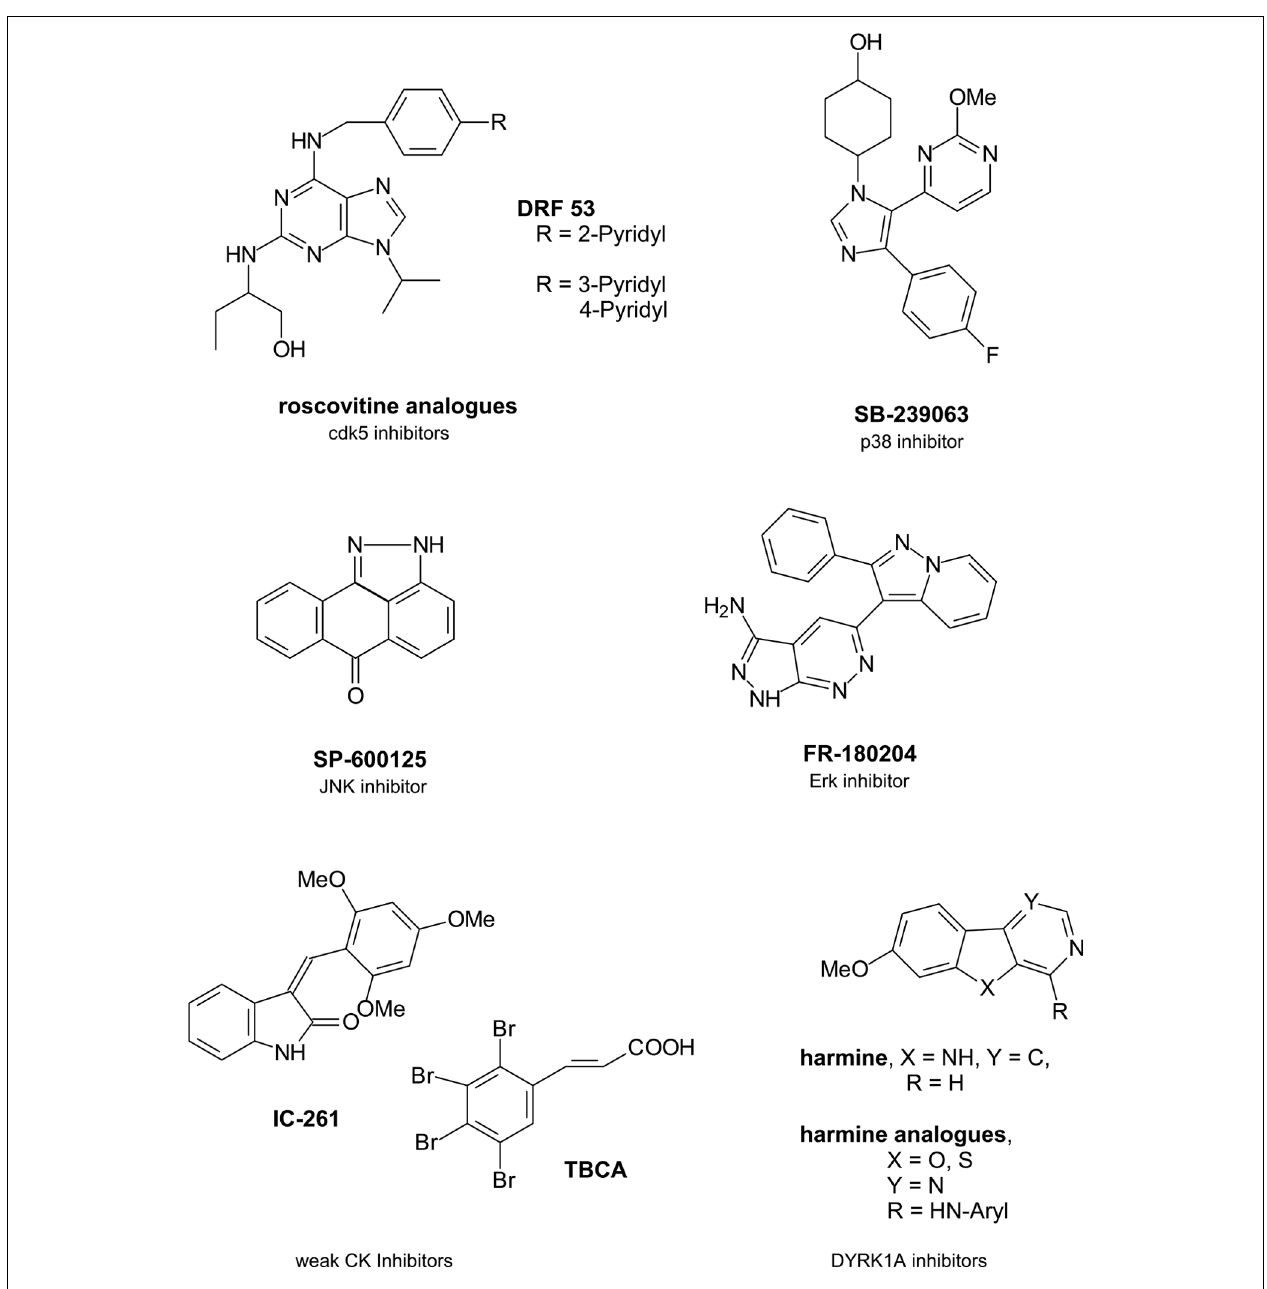
FIGURE 1 | Single protein kinase-targeting